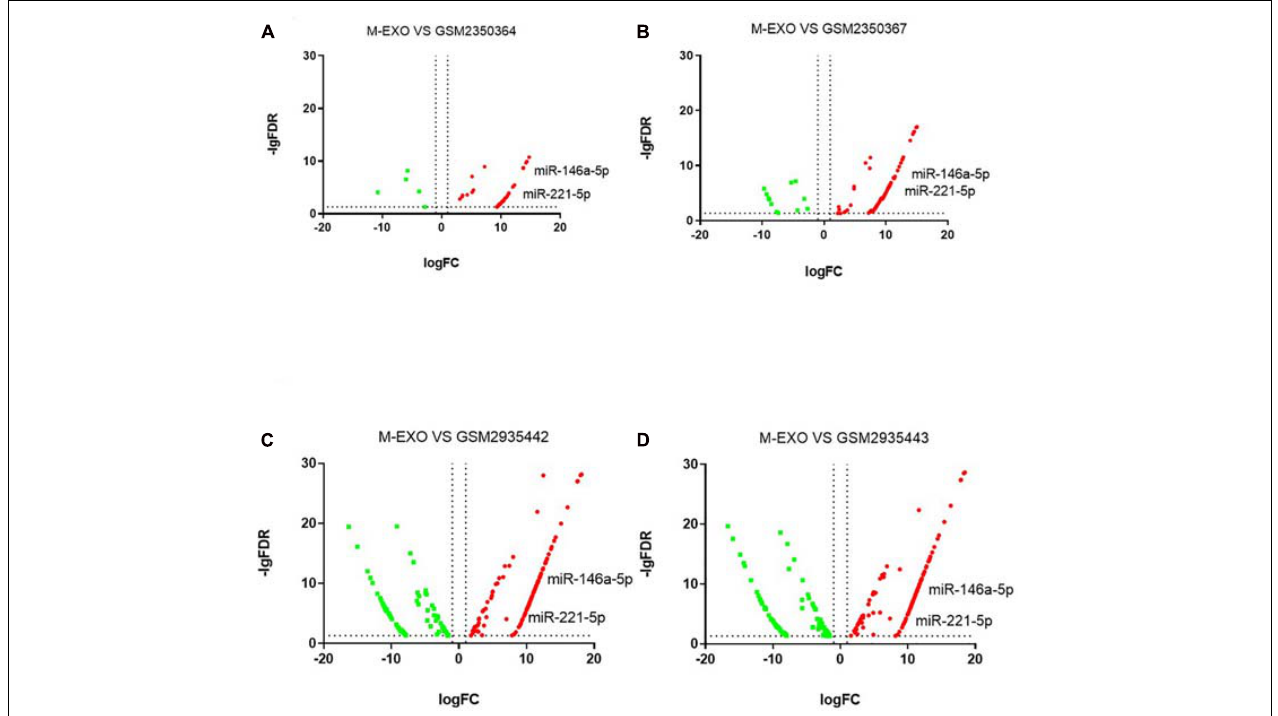
FIGURE 6 | Comparison between M-EXO and MUS groups. (A) DE miRNAs in M-EXO vs. MUS (GSM2350364); (B) DE miRNAs in M-EXO vs. MUS (GSM2350367); (C) DE miRNAs in M-EXO vs. MUS (GSM2935442); (D) DE miRNAs in M-EXO vs. MUS (GSM2935443).